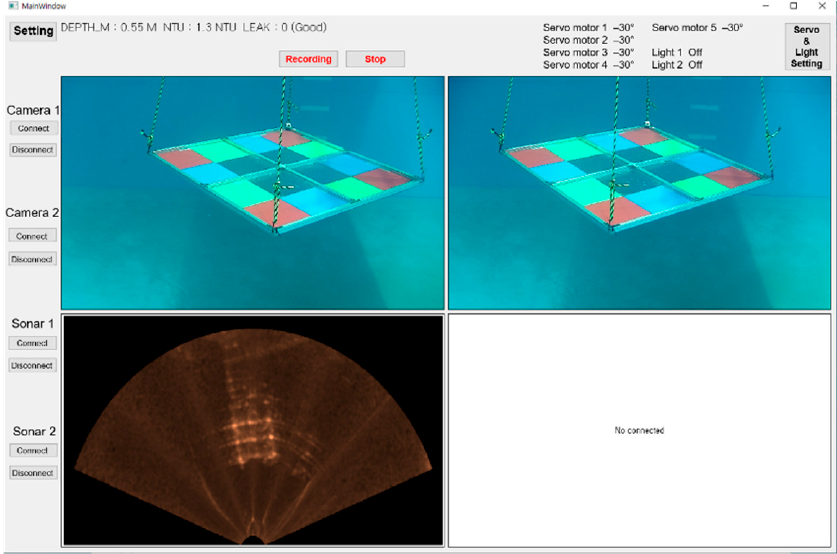
Figure 4. Software to control the display and acquisition of optical and sonar images, light operation,